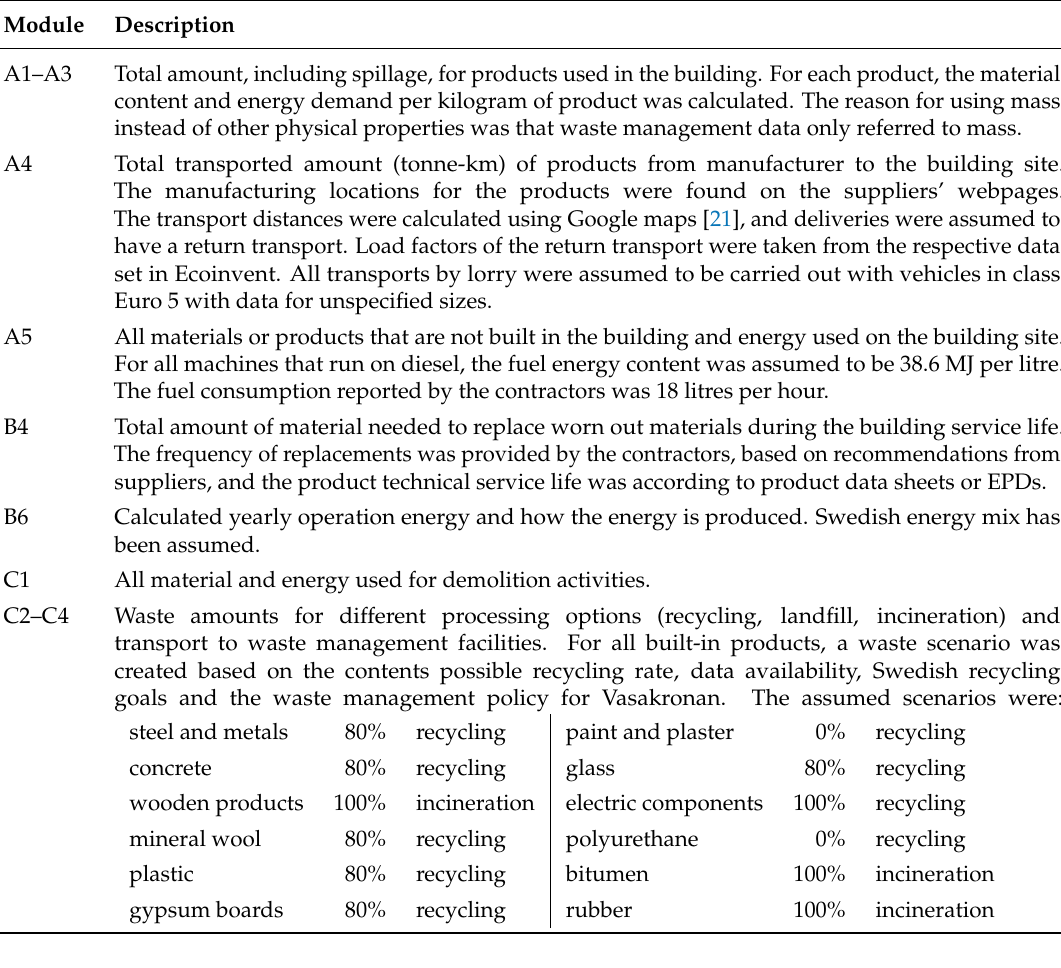
Table 1. Calculated data for each life cycle